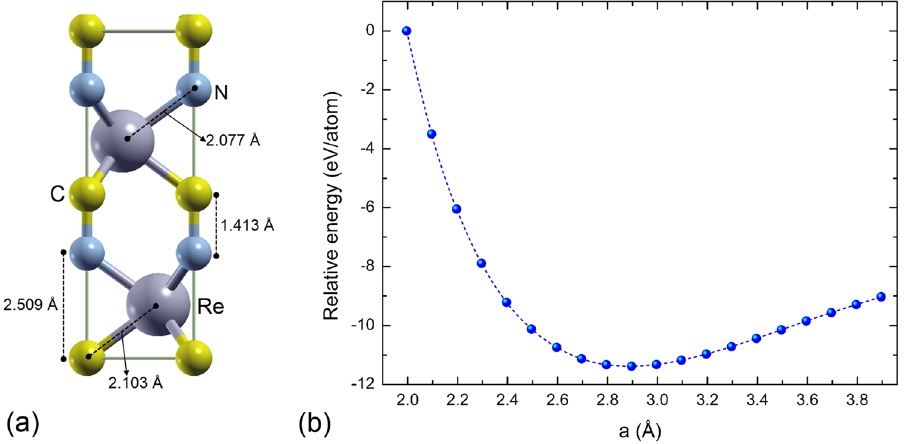
Figure 1. ( a ) ReCN bulk structure, and ( b ) Total energy as function of lattice parameter for bulk ReCN.